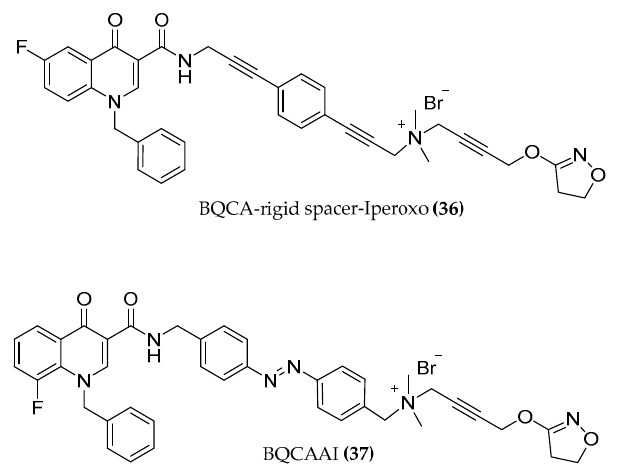
Figure 14. Structures of BQCAd/Iperoxo hybrids connected by a rigid linker and a photo-switchable moiety. Probably, a cation- π interaction between the three tyrosines Y104 3.33 , Y403 6.51 and Y426 7.39 of the so-called tyrosine lid with the rigid linker contributes to the delayed FRET signal. (Remodeling of the tyrosine lid. in Figure 15).